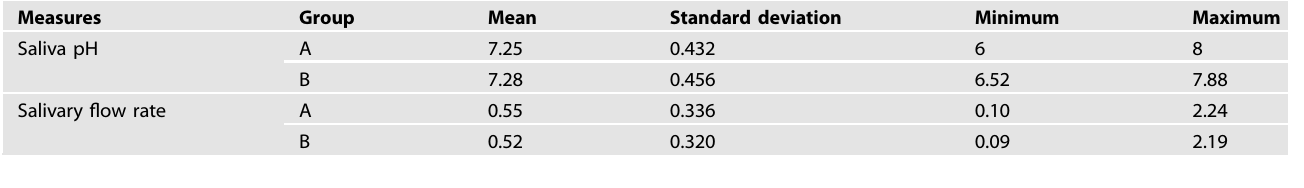
Table 2. Descriptive data of both salivary pH and salivary fl ow rate. Measures